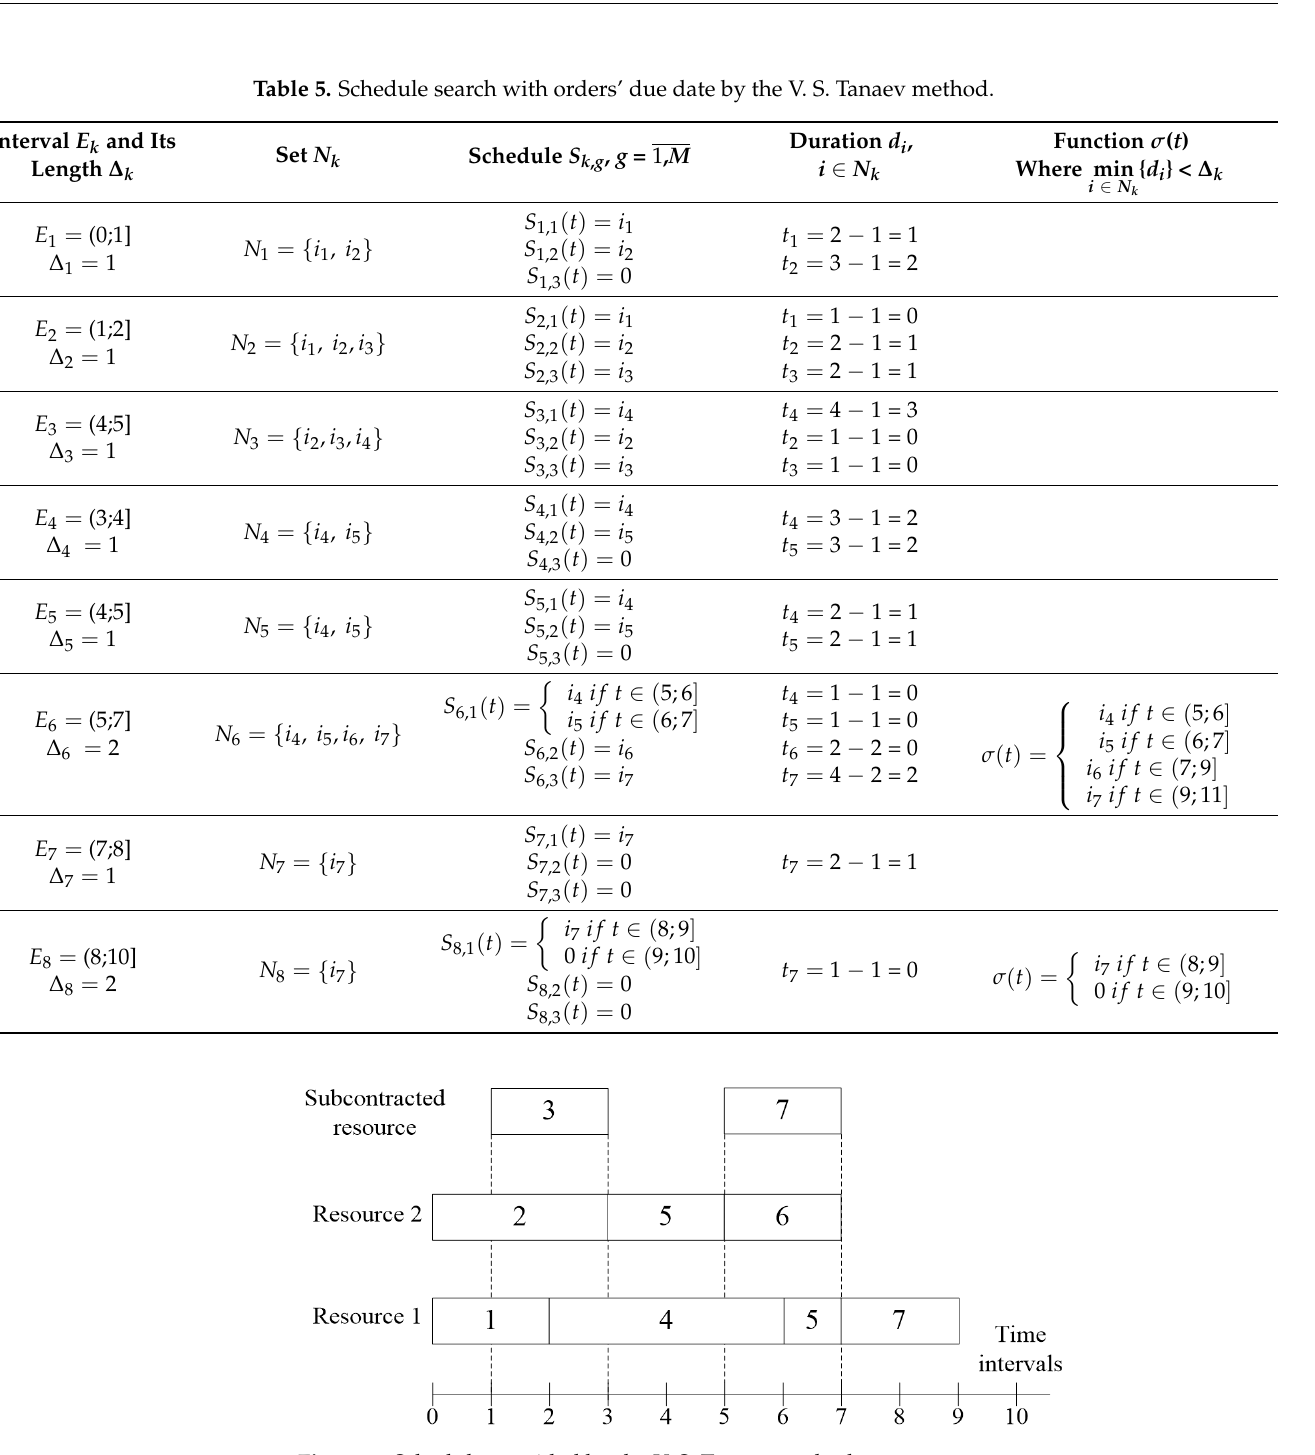
Figure 3. Schedule provided by the V. S. Tanaev method.